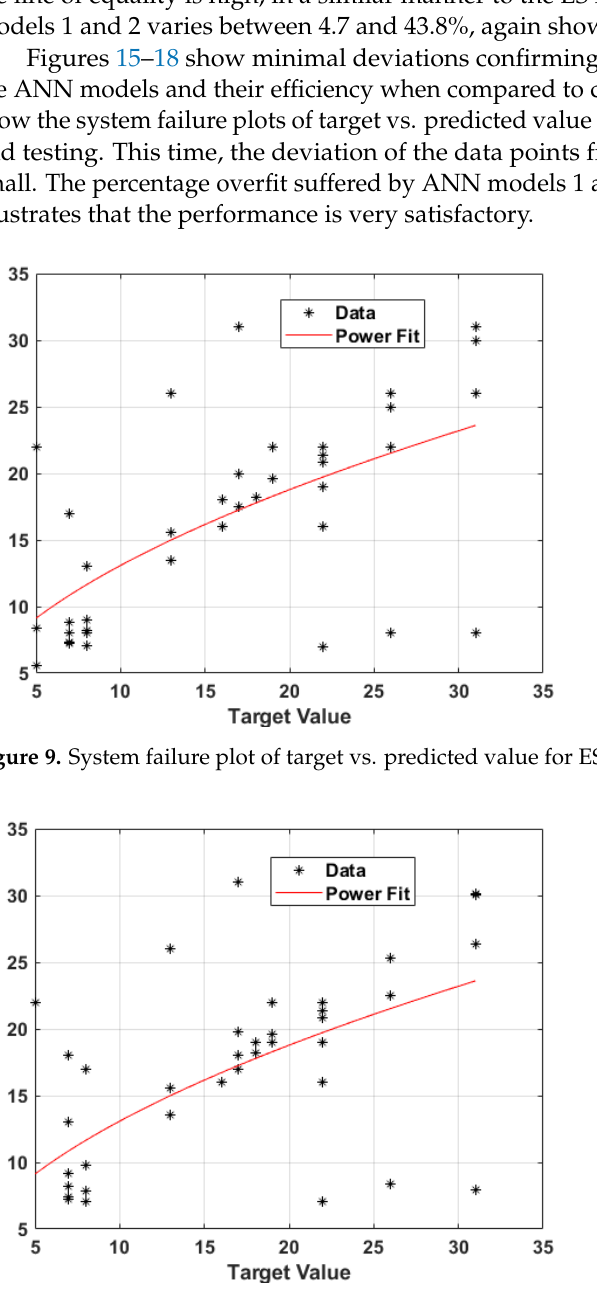
Figure 10. System failure plot of target vs. predicted value for ES Model